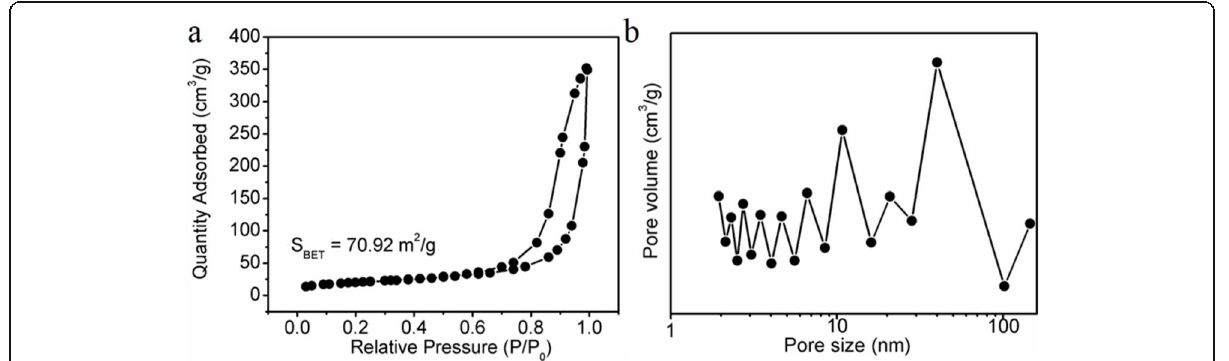
Fig. 2 a N 2 sorption isotherms of PPMs collected at 77 K; b pore size distributions of